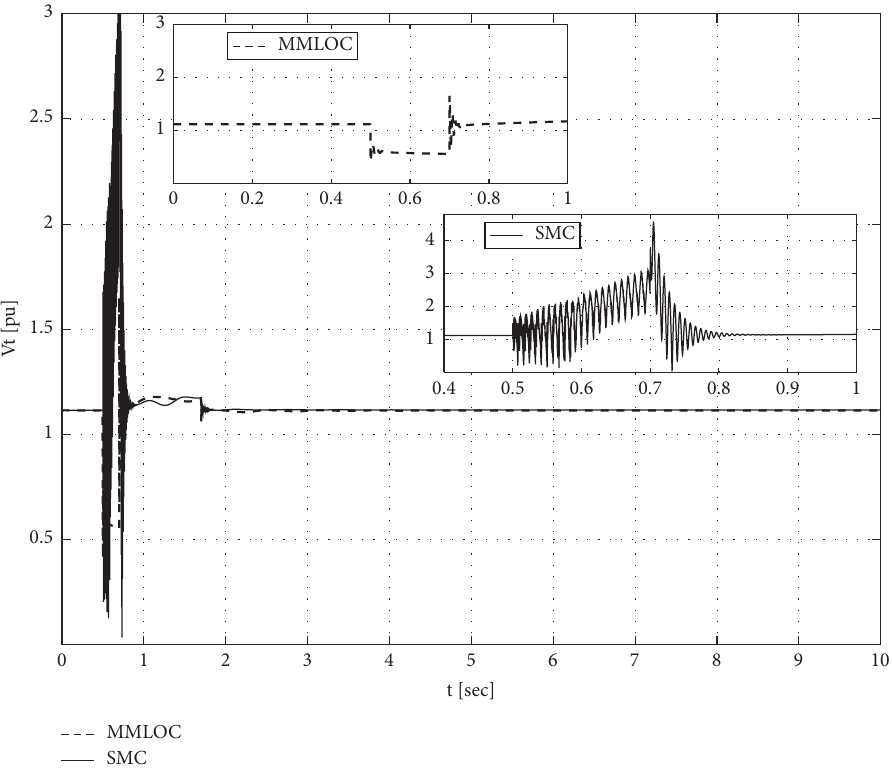
Figure 7: Terminal voltage of the generator with MMLOC and SMC.